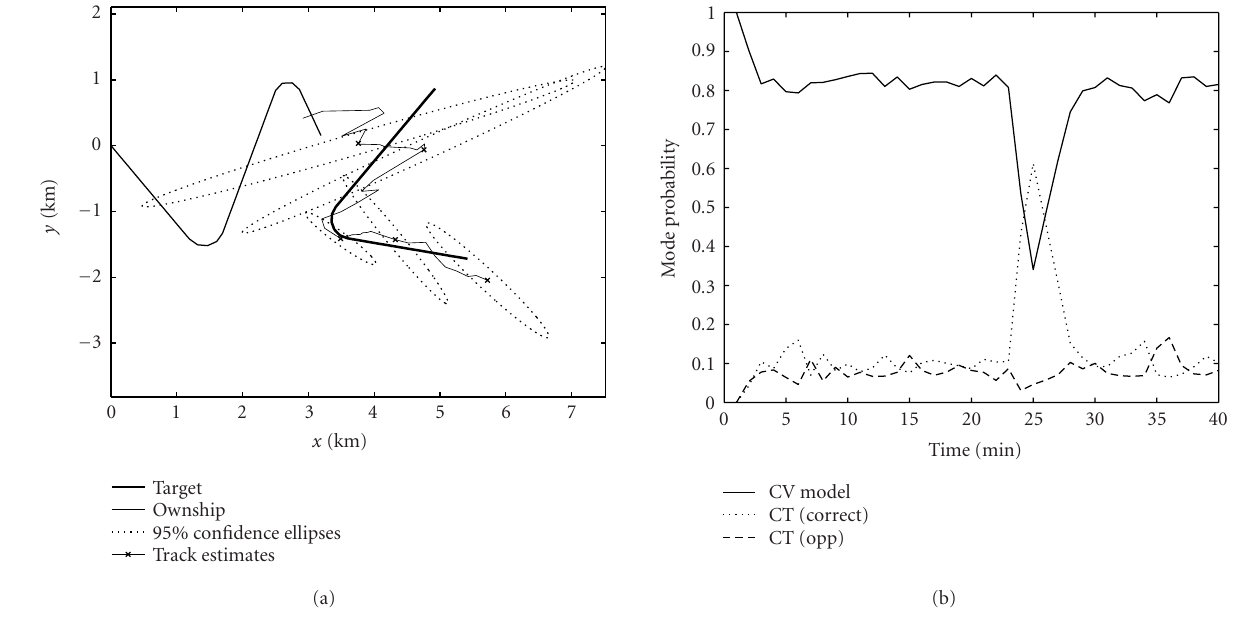
Figure 4: MMPF tracker results. (a) Track estimates and 95% confidence ellipses. (b) Mode probabilities. This is clear from the mode probability curves shown in Figure 3b, where we note that though there is a slight bump in the mode probability for the correct manoeuvre model, the algorithm is unable to establish the occurrence of the ma- noeuvre. The overall result is a track that is showing a ten- dency to diverge from the true